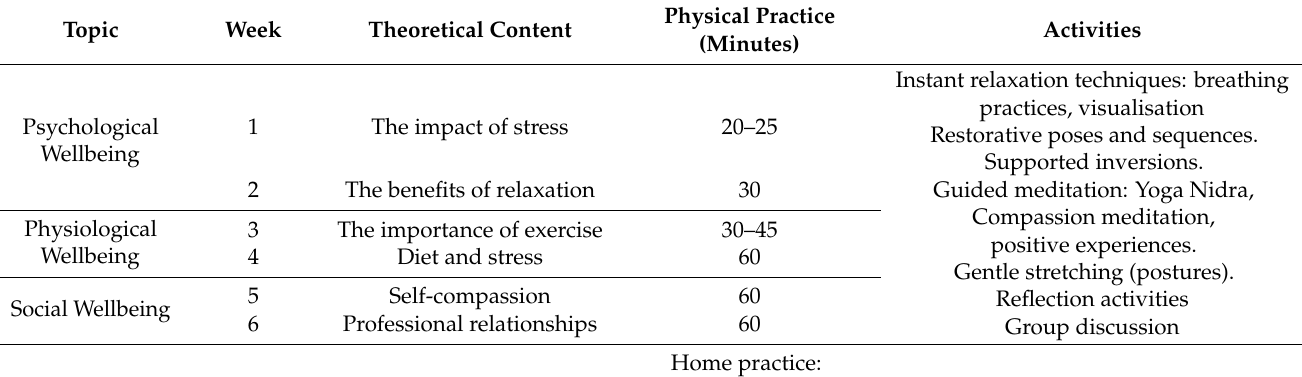
Table 3. Theoretical and practical program